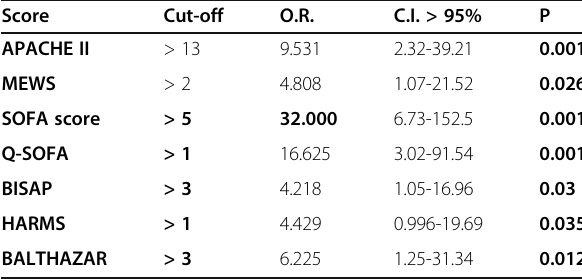
Table 5 Cut off determined for each score